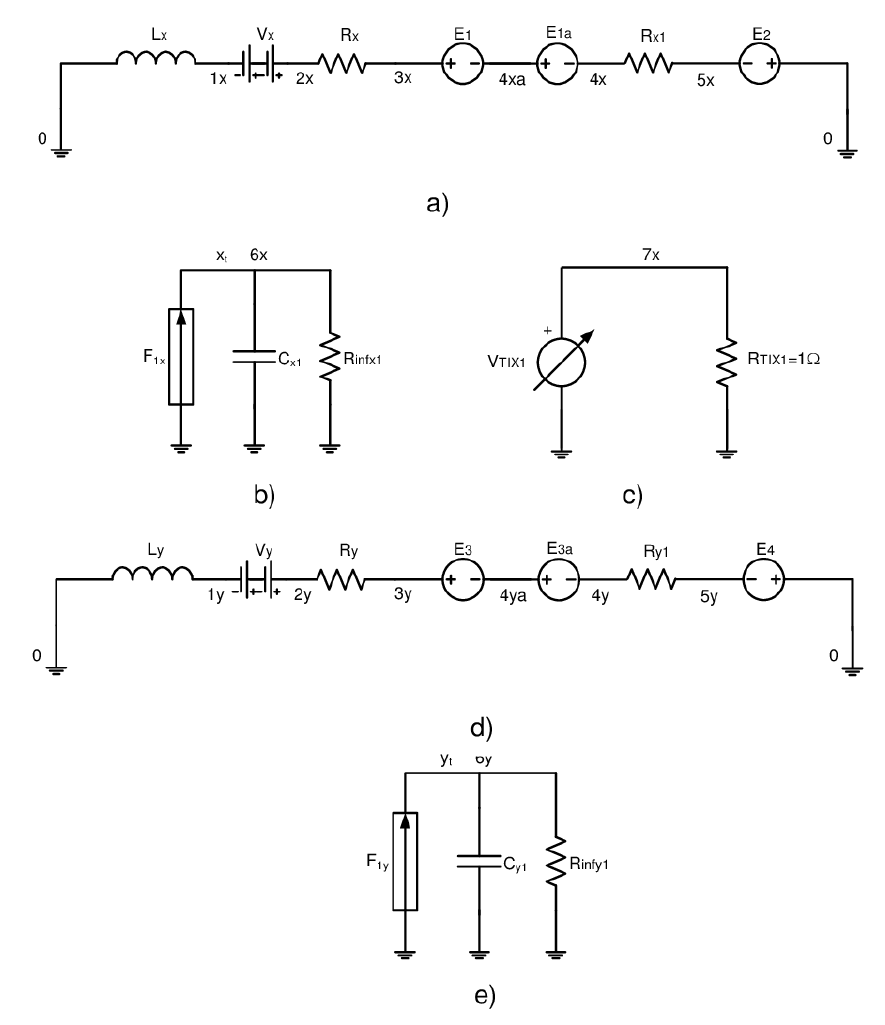
Figure 4 Network model, in x and y directions, of FFM on NaF and SFM on HOPG. a) and d) Main circuits, b) and e) auxiliary circuits to obtain x t and y t , and c) auxiliary circuit to obtain the